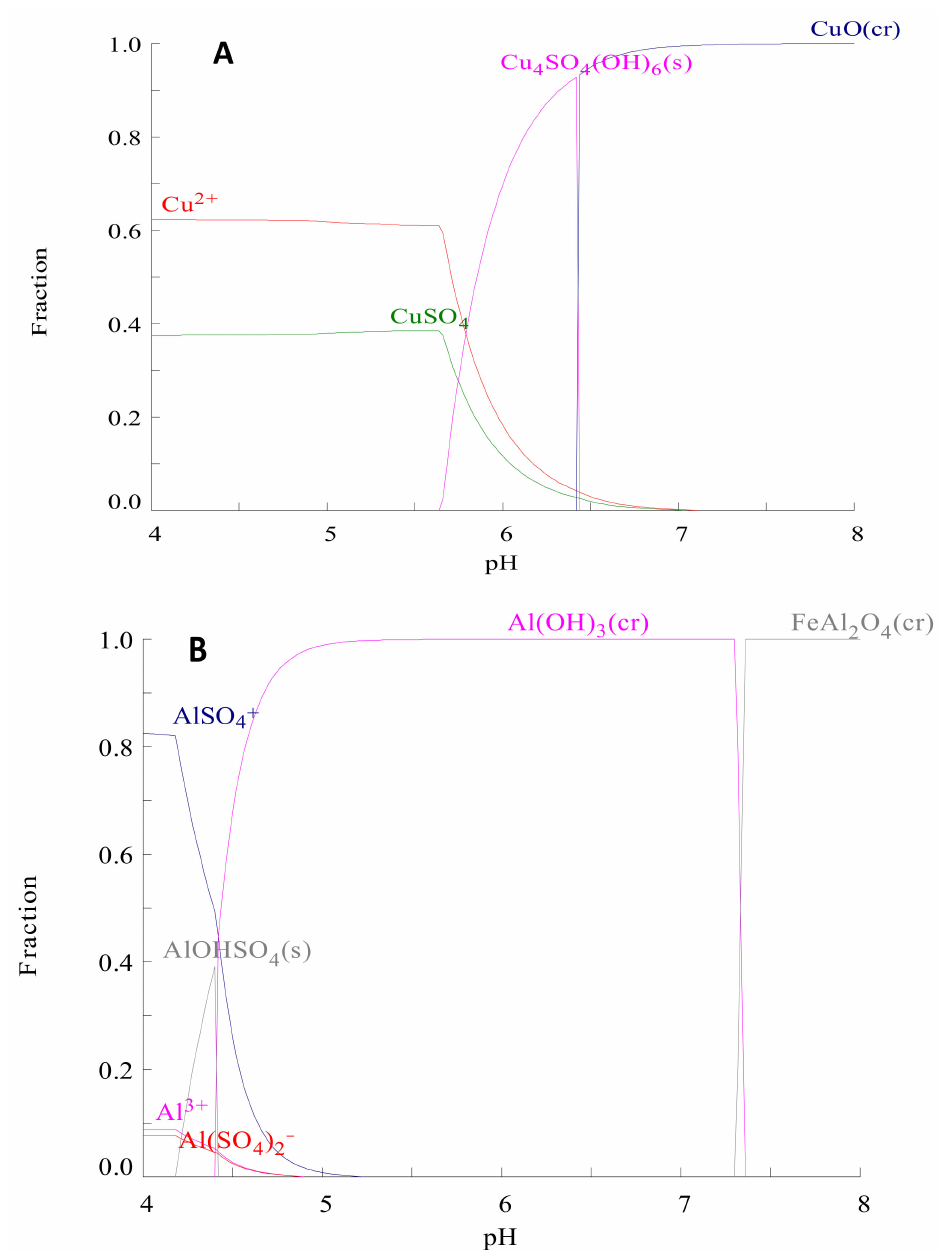
Figure A4. Predicted species distribution curves for ( A ) Cu(II) and ( B ) Al(III) in the synthetic solution as a function of pH at 25 ◦ C, elaborated with the MEDUSA software suite. Concentrations: [Cu(NO 3 ) 2 ] = 1.6 × 10 − 4 M, [FeSO 4 ] = 3.9 × 10 − 4 M, [ZnSO 4 ] = 5.1 × 10 − 3 M, [Cd(NO 3 ) 2 ] = 8.8 × 10 − 6 M, [Pb(NO 3 ) 2 ] = 2.4 × 10 − 5 M and [Al(NO 3 ) 3 ] = 1.5 × 10 − 4